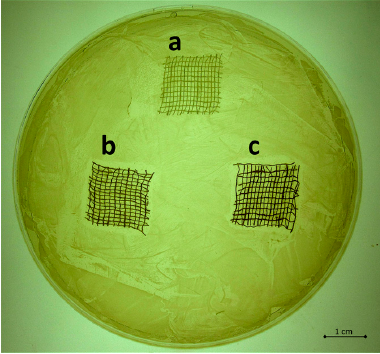
Figure 2. Agar diffusion tests on S. aureus : ( a ) untreated sample; ( b ) sample treated with 0.5 wt/v % silver; ( c ) sample treated with 4 wt/v % silver. The presence of the inhibition zone to bacterial growth is clearly visible around both the silver-treated samples.